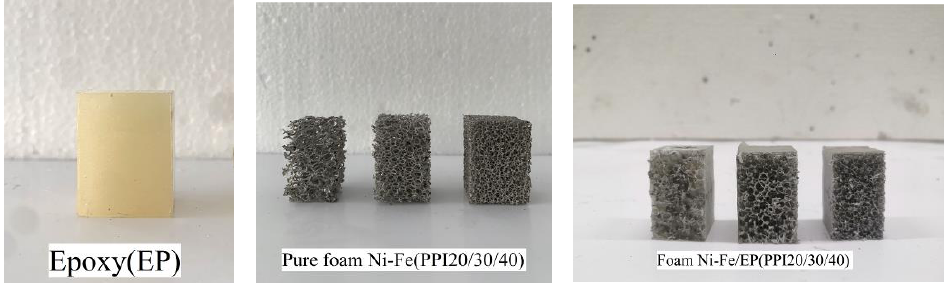
Figure 3. Compression specimen of the pure epoxy, foam Ni-Fe, and foam Ni-Fe/EP interpenetrat- ing phase composites.